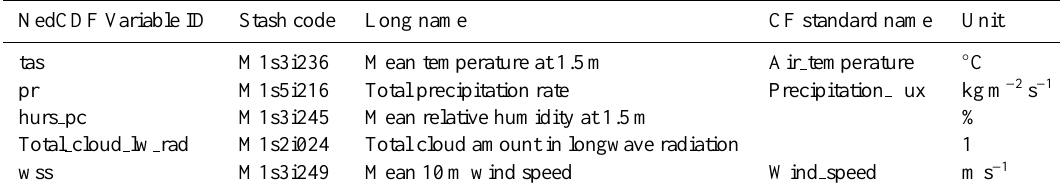
Table 2. HadRM3-PPE variables used to derive Future Flows